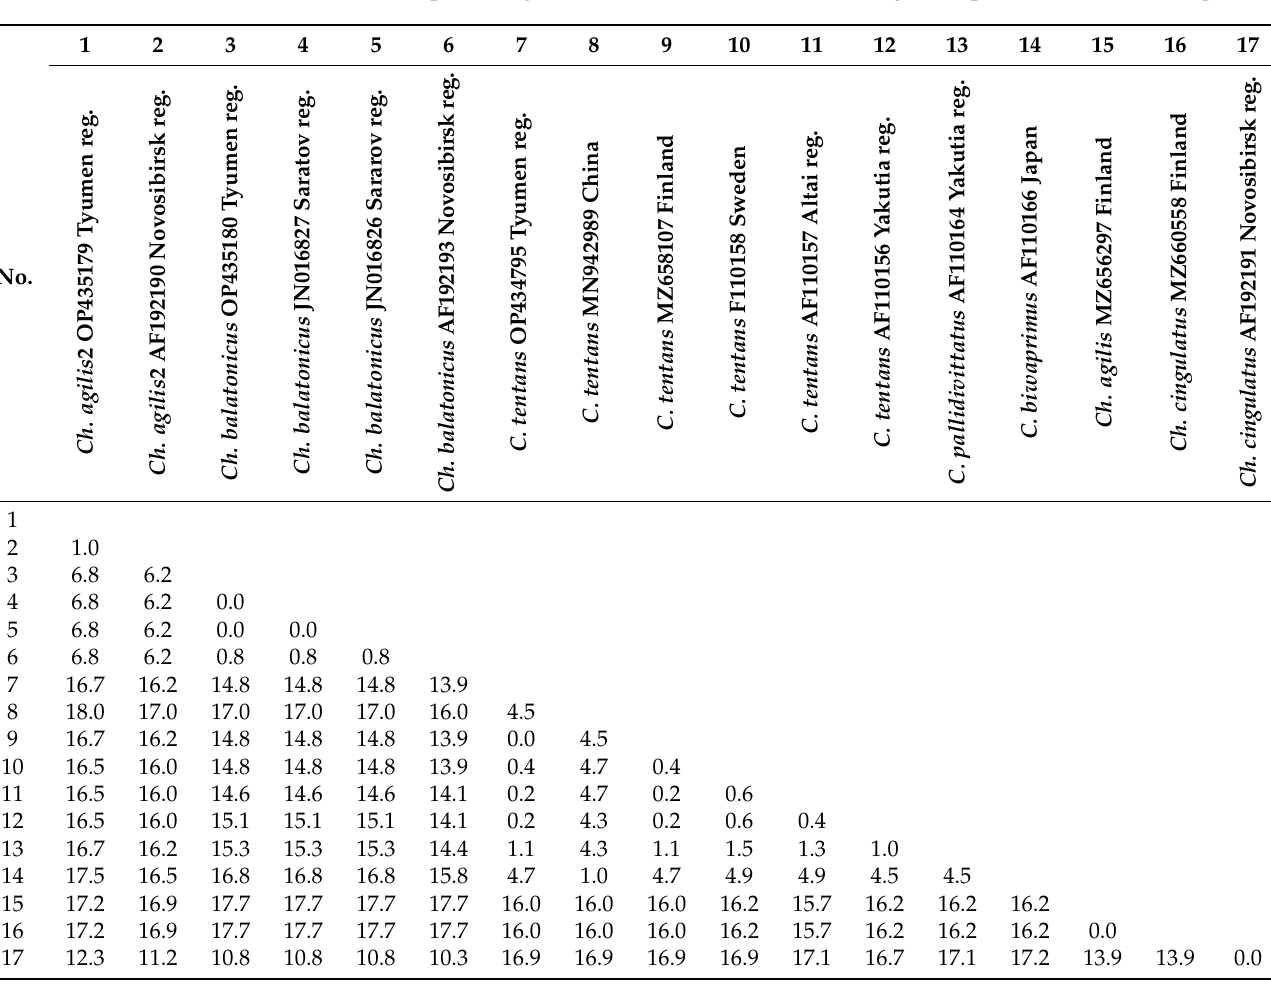
Table 1. The pairwise genetic distances (K2P) between COI gene sequences of Chironomus